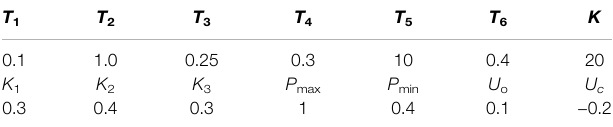
TABLE 1 | Parameters of the governor